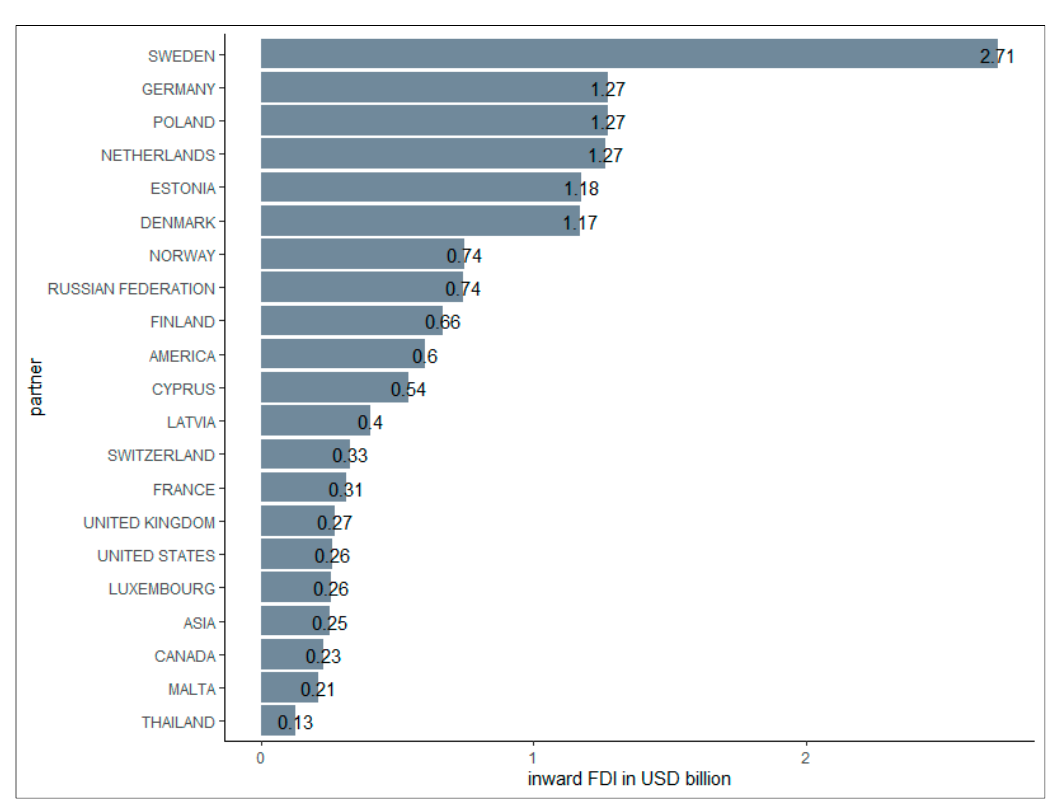
Figure A4. Average inward FDI stocks by partners in Latvia across 2004–2017.